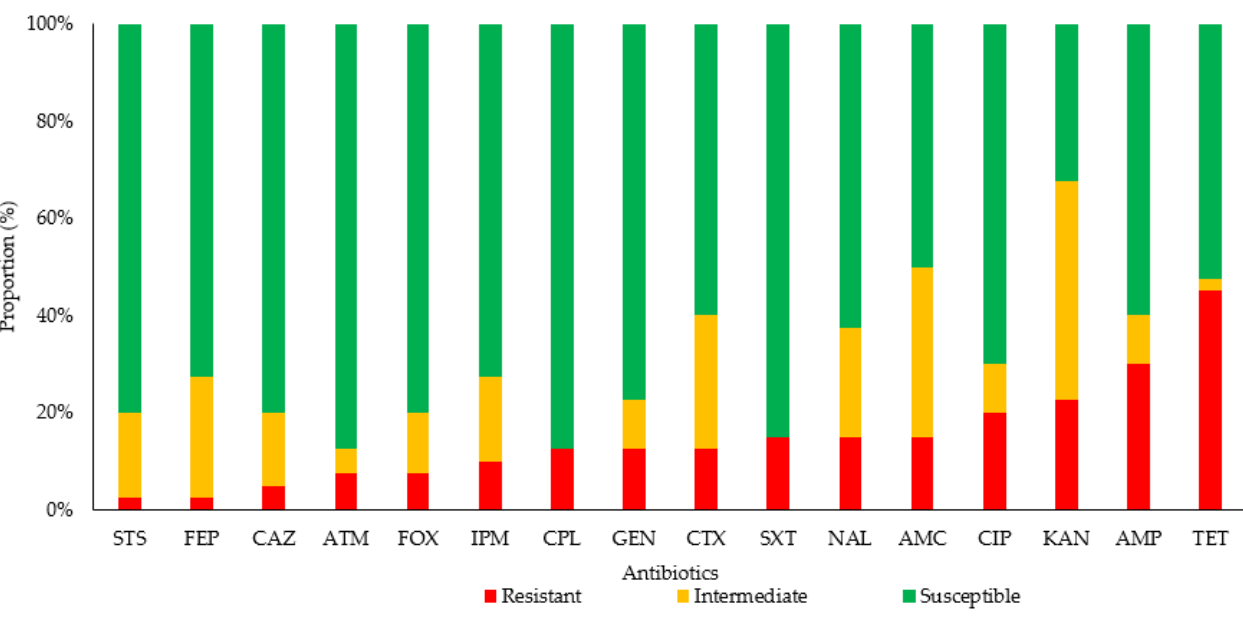
Figure 1. Proportion of antibiotic sensitivity and resistance in E. coli strains isolated from companion dogs. Abbreviations: AMC, amoxicillin – clavulanate; AMP, ampicillin; ATM, aztreonam; CAZ, ceftazidime; CIP, ciprofloxacin; CPL, chloramphenicol; CTX, cefotaxime; FEP, cefepime; FOX, cefoxitin; GEN, gentamicin; IPM, imipenem; KAN, kanamycin; NAL, nalidixic acid; STS, streptomycin; SXT, trimethoprim – sulfamethoxazole; TET, tetracycline. Table 2. Phenotypes and genotypes of E. coli strains isolated from domestic dogs.